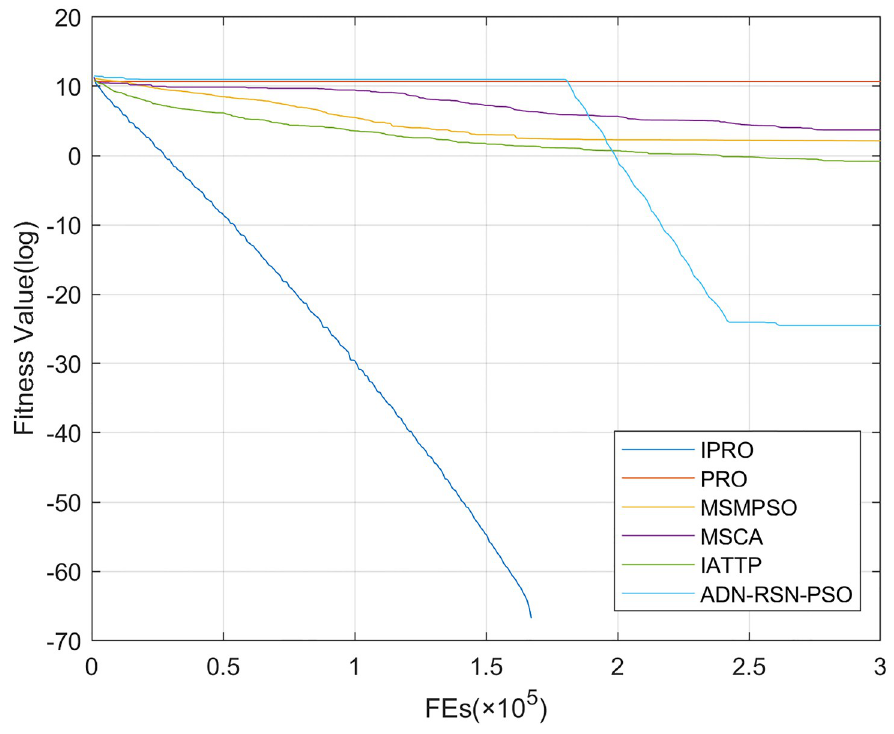
Fig 1. Convergence curves on F1.